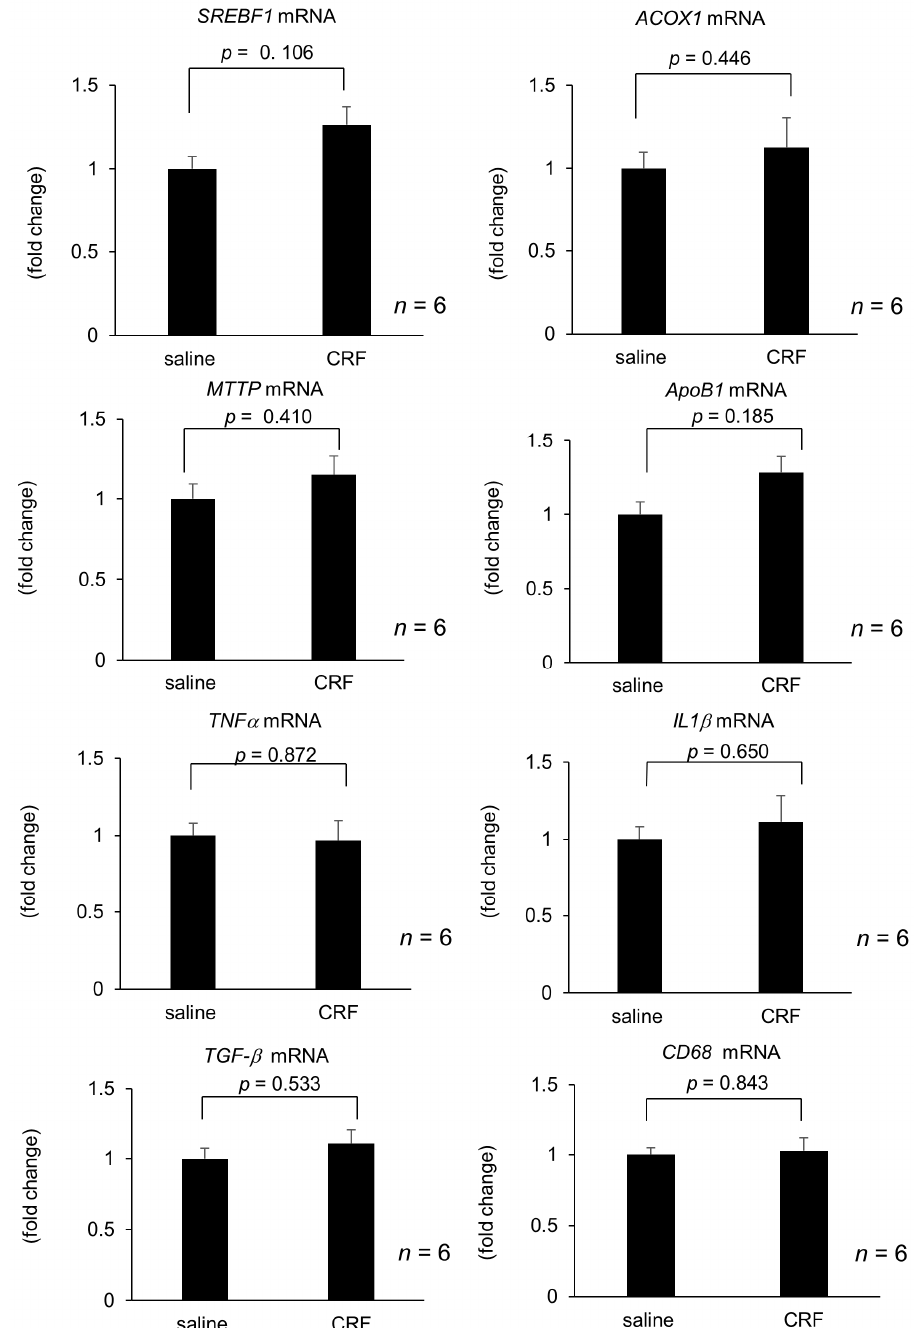
Figure 3. Effect of intravenous injection of CRF on hepatic gene expression during experimental period. The number of each group in rats was six. Hepatic lipid metabolism and inflammation-related gene expression 6 h after intravenous CRF administration. Relative mRNA expressions of SREBF1, ACOX1, MTTP, ApoB1, TNF α , IL1 β , TGF β , and CD68 were evalu- ated and compared with respective saline control. Statistical analysis was performed using Student’s t -test, and data are expressed as means ± standard error